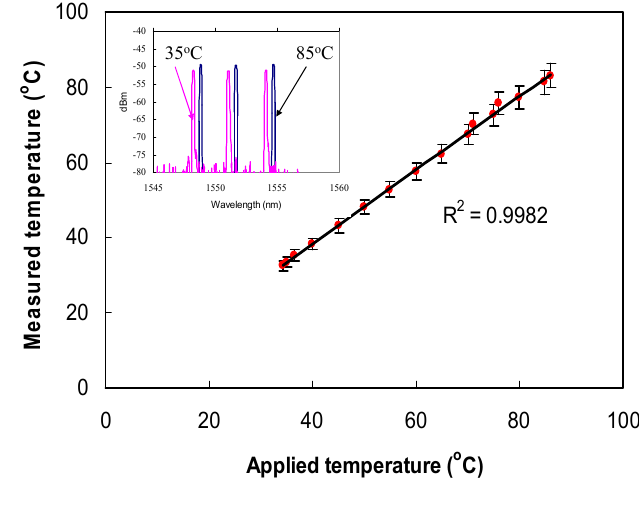
Figure 3. Temperature performance of grating sensor. Inset: output spectrum for the fiber Bragg grating sensors with an applied temperature at 35 o C (black color) and 85 o C (magenta color), respectively.